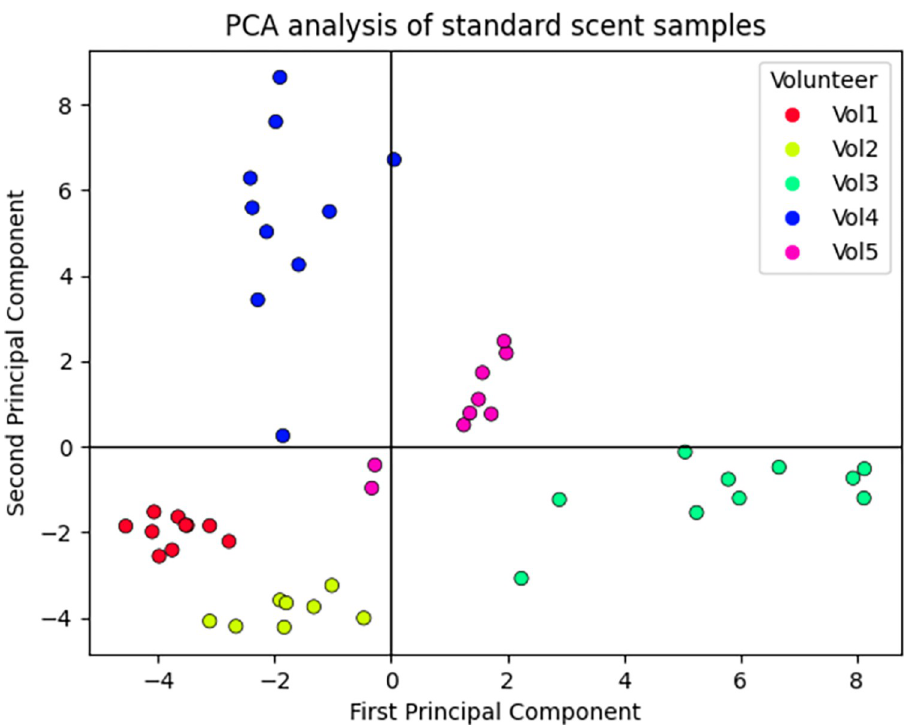
Fig 5. PCA of the scent collected from glass beads samples and a shot cartridge sample. This model was based on N = 50 ratios with the least intrasubject SD for each volunteer. The T 2 was set to 25%. 57 peak area ratios are the intersection of all volunteer sets, and these ratios were present in more than 25% of the samples. The first two components described 42.10% of the variance in the data. Further comments on the PCA analysis setup are given in S1 File.